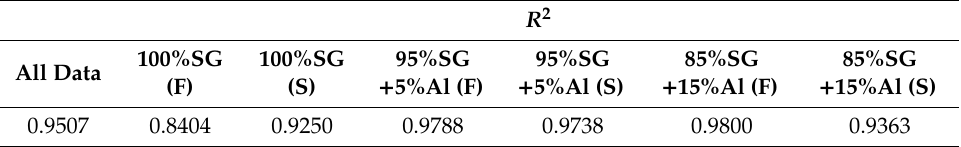
Table 4. Coe ffi cient of determination R 2 for the Linear Fit